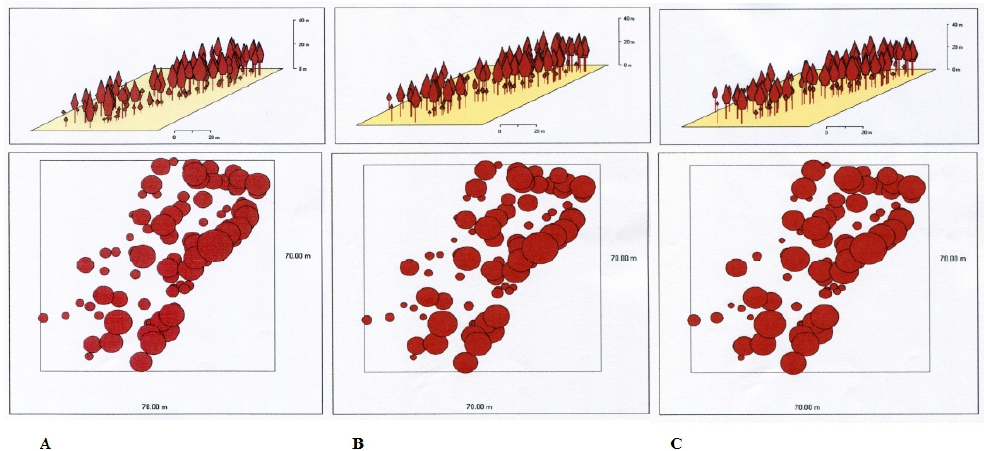
Figure 2. Growth simulation model for study site 1 (autochthonous mountain Norway spruce forest) under a non ‐ intervention management: status quo ( A ), and visualization of the future forest development for the period of 25 years ( B ) and 50 years ( C ). Red = Picea abies.